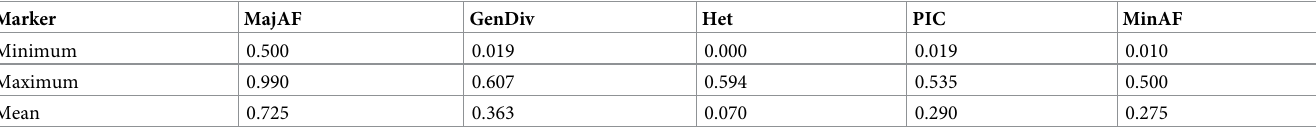
Table 3. Summary statistic of 1691 SNP markers used to study the genetic diversity. Marker MajAF